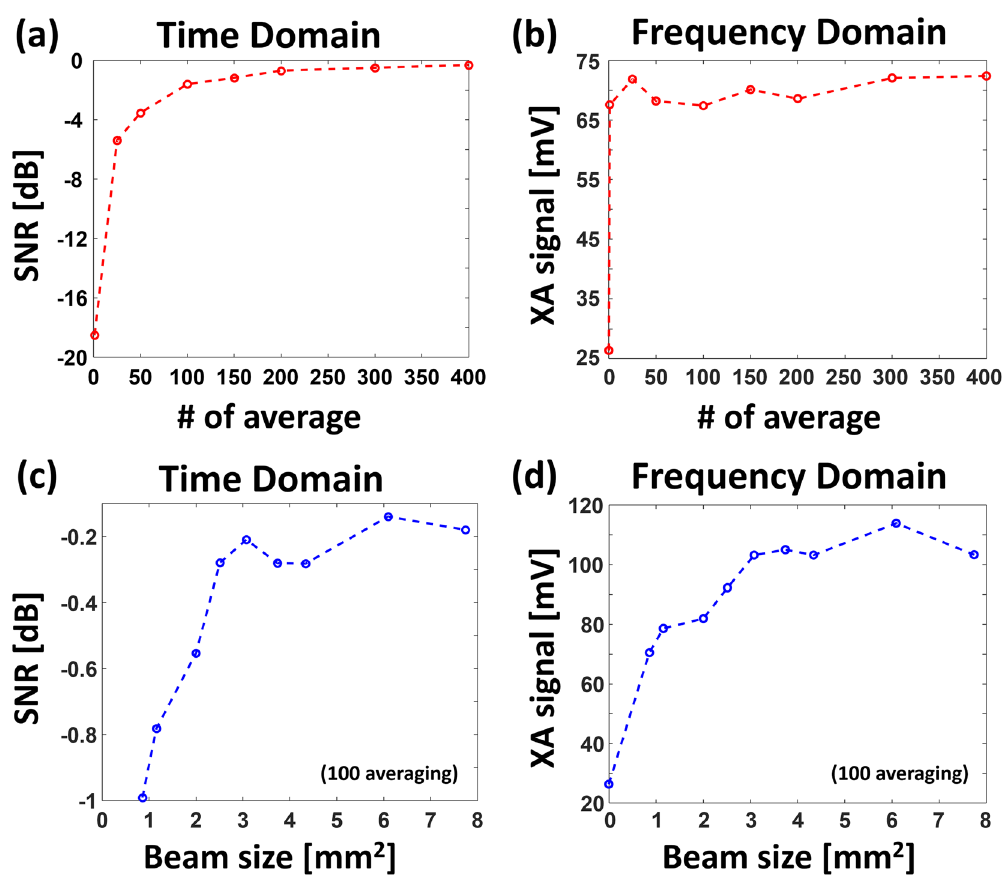
Figure 3. ( a ) Signal-to-noise ratios (SNRs) vs. the number of averages in the time domain. ( b ) XA signal amplitudes vs. the number of averages in the frequency domain. ( c ) SNRs vs. X-ray beam sizes in the time domain. ( d ) XA signal amplitudes vs. X-ray beam sizes in the frequency domain.